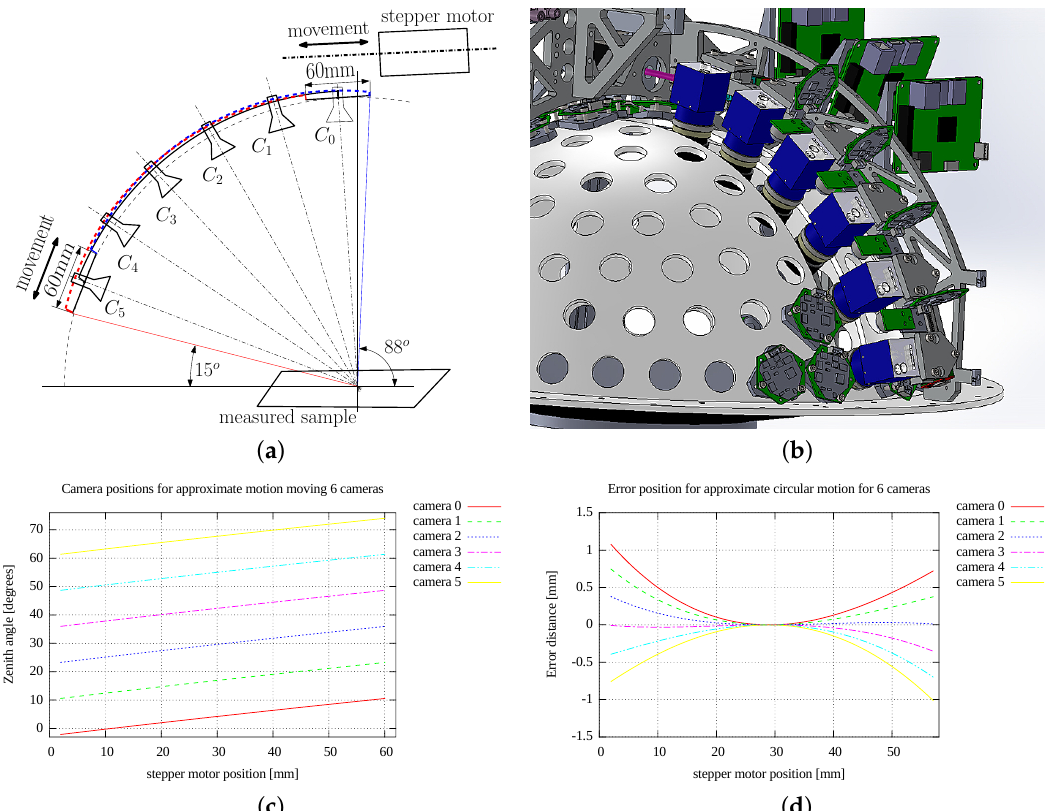
Figure 7. ( a ) The principle of six camera motion using two short linear guides 60 mm long carrying an arc with the cameras; the black circular arc is for the null position in the centre of linear guides, the blue dashed arc and the red dashed arc are the low and high dead centre positions of the motion, respectively; ( b ) solid drawing of the camera motion mechanism; ( c ) camera positions in relation to stepper motor position; ( d ) radial camera position error taken as the distance of camera axis from the centre of hemisphere as a function of the stepper motor